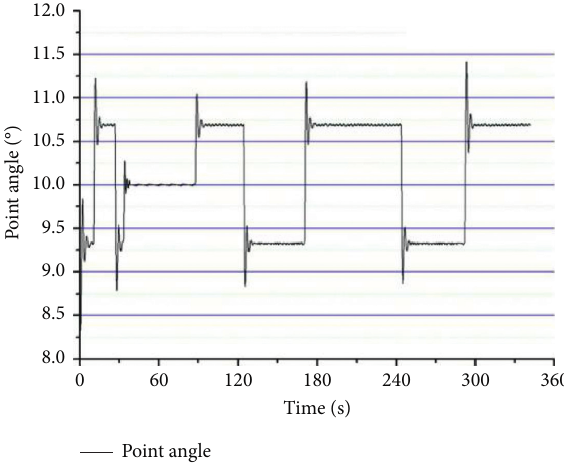
Figure 22: Tracking effect when 1 ° /s triangle wave input.